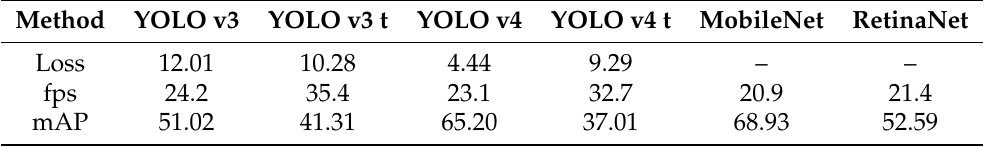
Table 2. This table presents value of loss function, data processing frequency (fps) and mean averaged precision (mAP) for networks after finishing the